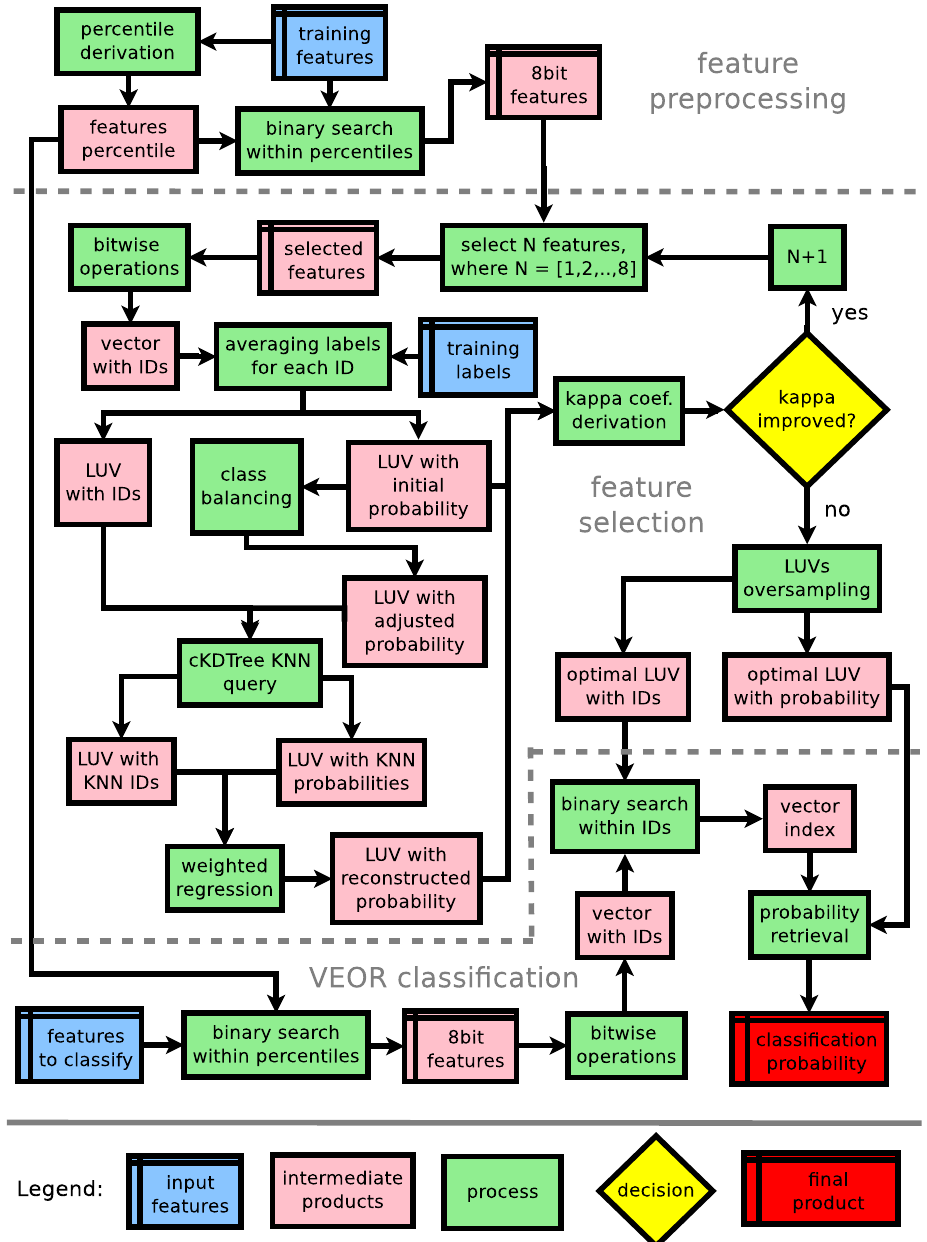
Figure 3. The VEOR algorithm